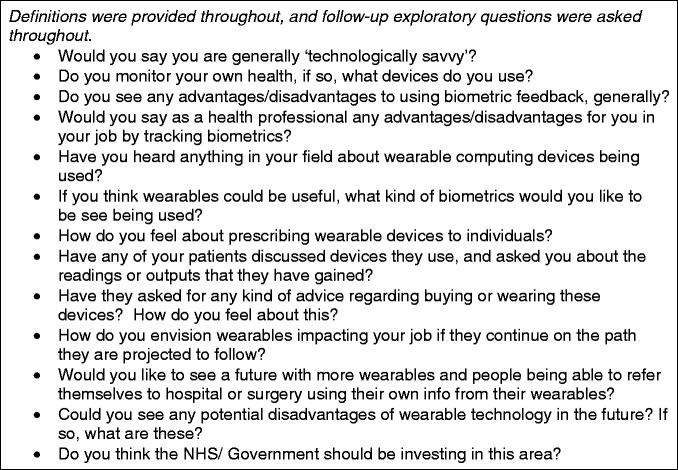
Interview schedule.